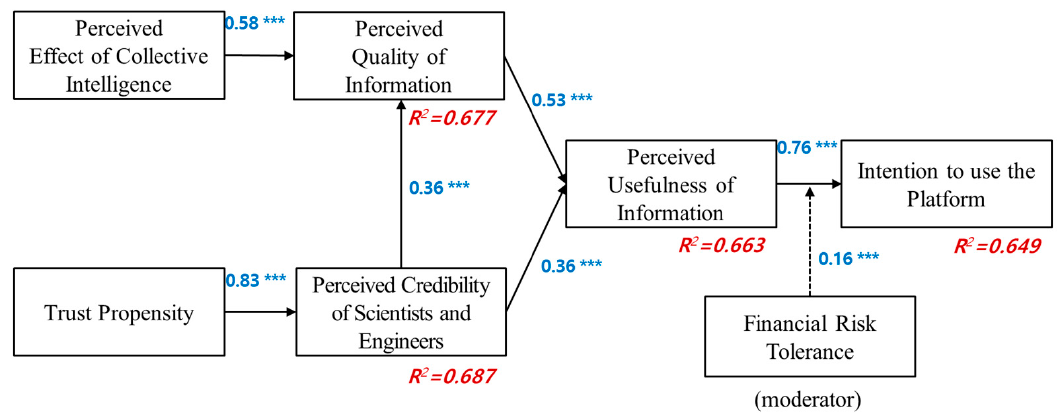
Figure 2. The results of a hypothesis testing. Note: *** p < 0.001